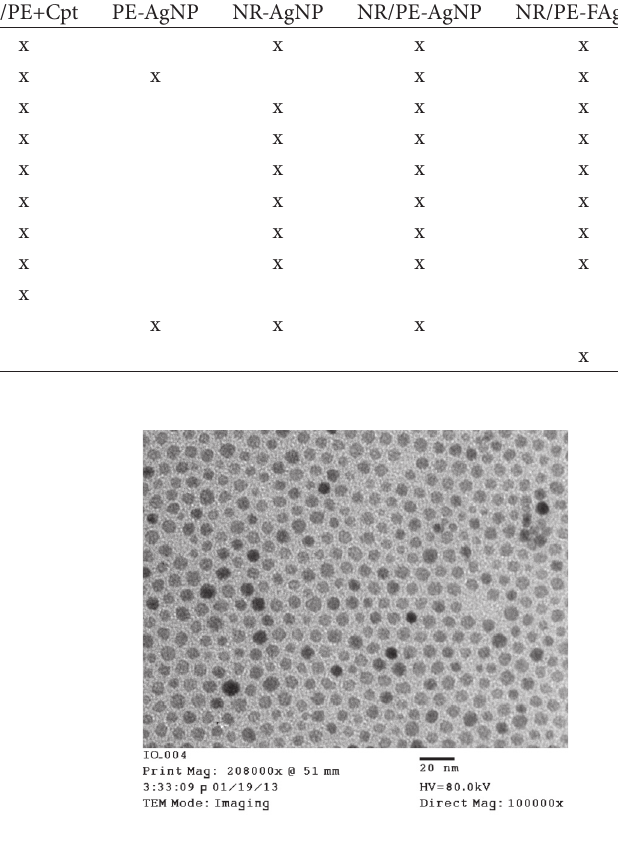
Figure 2: TEM image of Fe 3 O 4 NP dispersed in